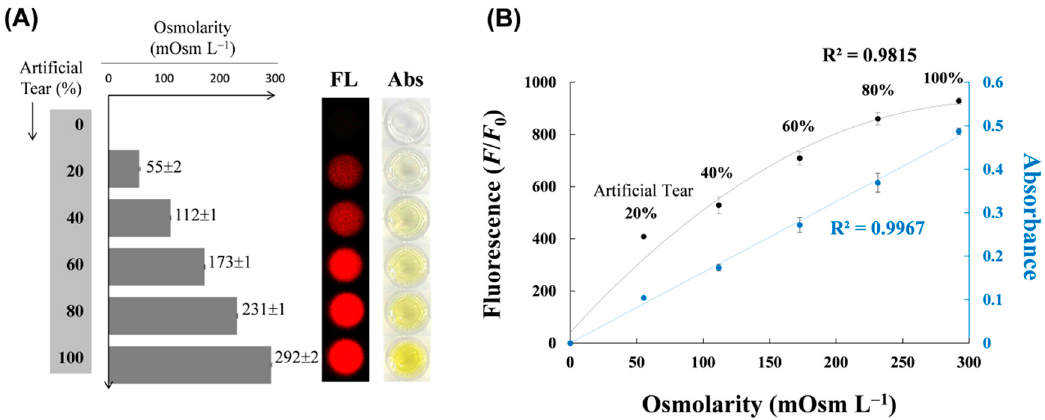
Figure 5. Relationship between osmolarity and sodium ions measured by DNAzymes in artificial tears. ( A ) Osmolarity (mOsm L − 1 ) was displayed with gray bars as a function of artificial tear concentration, which was compared with fluorescent (red, left) and colorimetric image (yellow, right) via sequential DNAzyme reactions; ( B ) The plotted graph represents the relationship between osmolarity and each detection mode as a function of tear concentration. The standard deviation was obtained from three independent experiments.